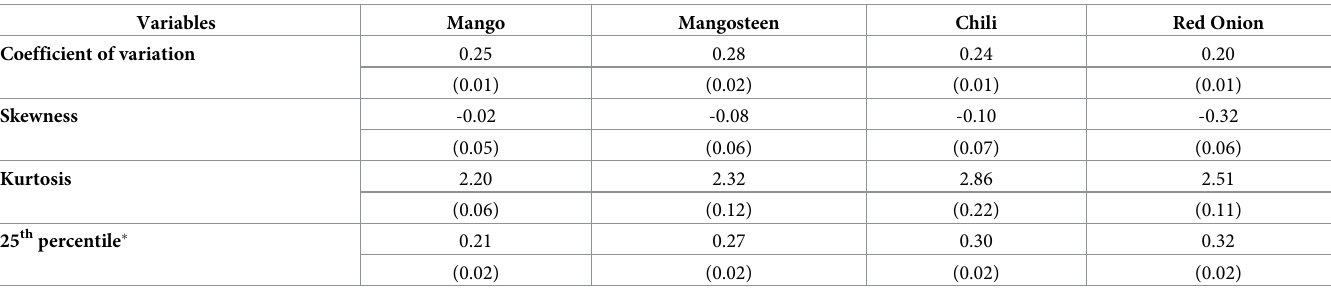
Table 2. Measures of production